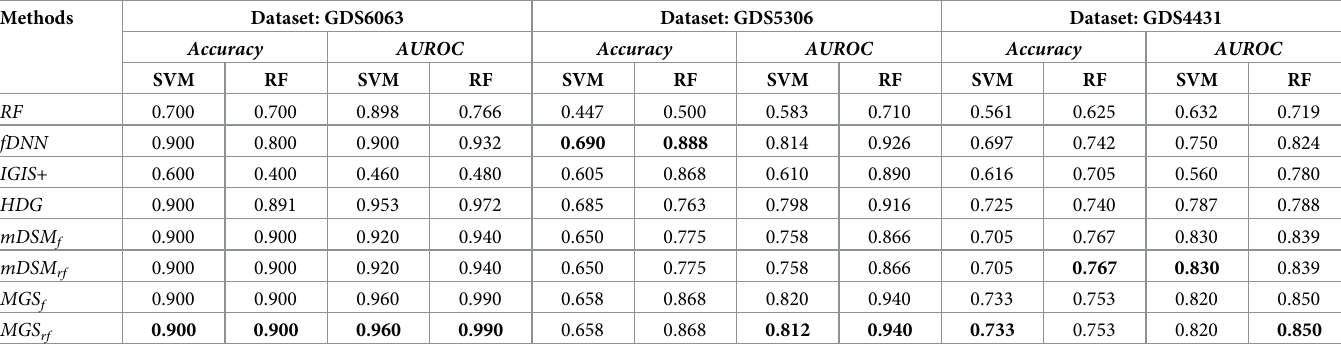
Table 3. Classification accuracy and AUROC of different methods for balanced datasets.